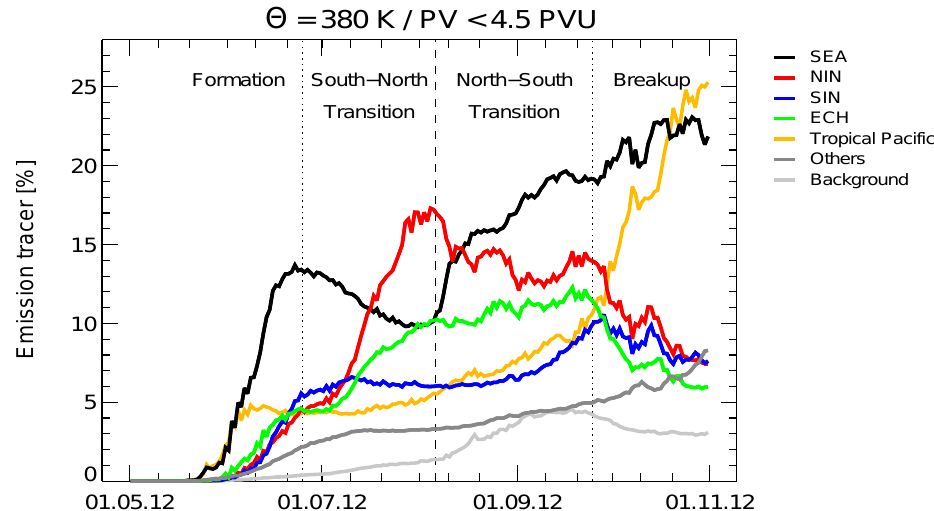
Figure 8. Temporal evolution of different emissions tracers from Southeast Asia (SEA, black), northern India (NIN, red), southern India (SIN, blue), eastern China (ECH, green), tropical Pacific Ocean (yellow), and from all other land masses plus tropical Atlantic/Indian Ocean (others, dark grey) within the Asian monsoon anticyclone at 380K from May 2012 until the end of October 2012. Contributions of boundary sources not considered in the defined emissions tracers listed in Table 1 are summarized as background (light grey). The shown percentages are mean values calculated for air masses in Asia in the region between 15 and 50 ◦ N and 0 and 140 ◦ E at 380 ± 0 . 5K (see black rectangles in Fig. 7) with PV values lower than 4.5PVU, marking the edge of the